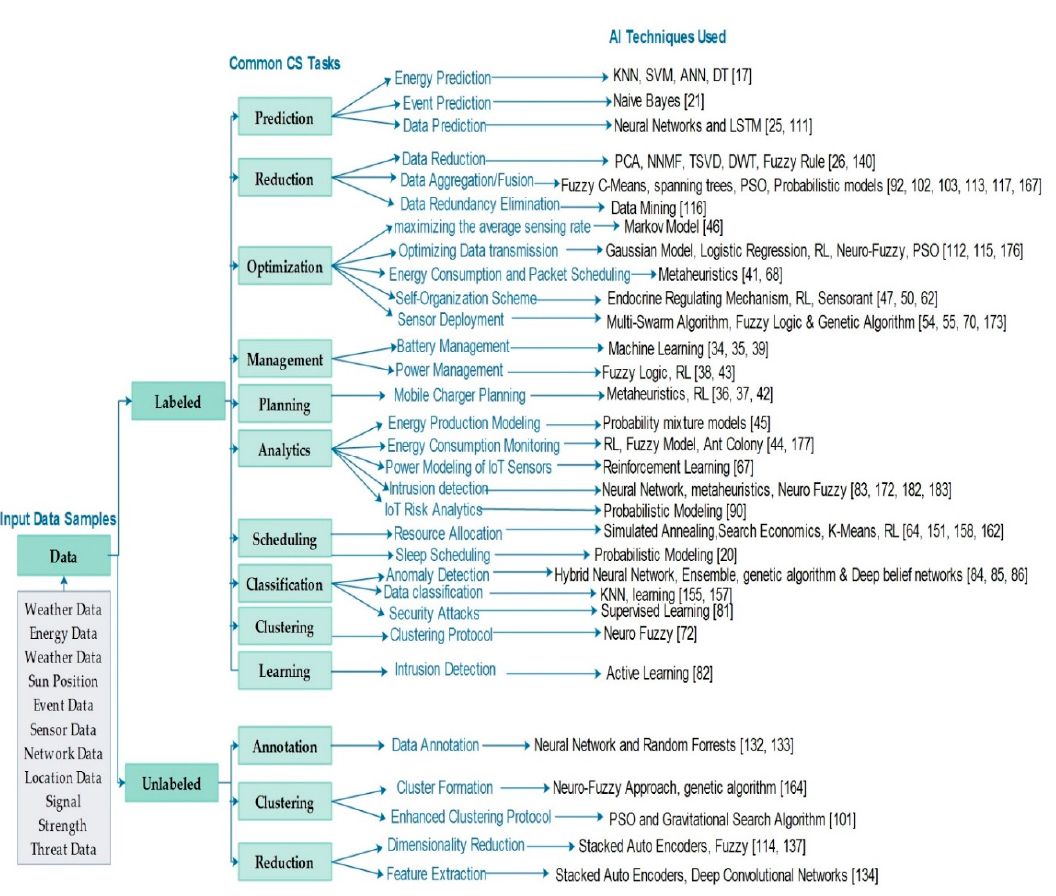
Figure 10. Classification of AI techniques over for CS Solutions.